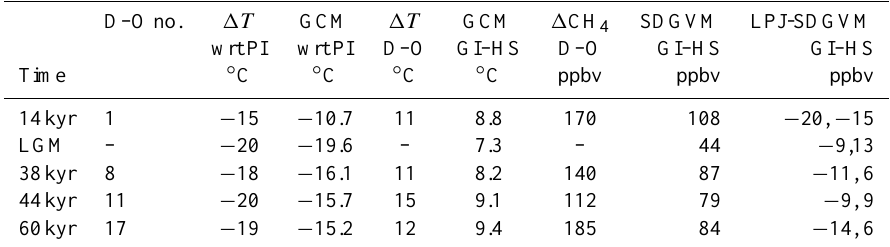
Table 1. Comparison of GCM and emission model simulations and ice-core data for Greenland (Blunier and Brook, 2001; Flückiger et al., 2004; Masson-Delmotte et al., 2005; Huber et al., 2006; Wolff et al., 2010).